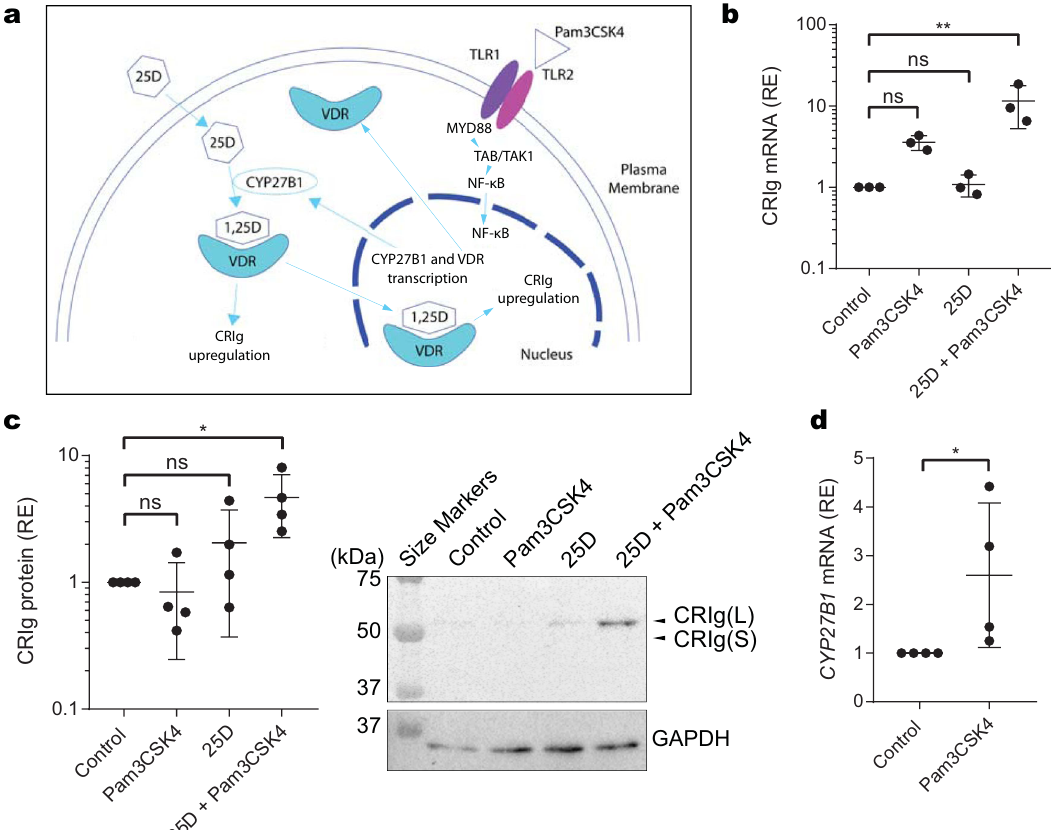
Fig. 4 Vitamin D 3 promotes CRIg expression in macrophages treated with the TLR1/2 agonist Pam3CSK4. a Schematic diagram showing engagement of TLR1/2 inducing enhanced expression of CYP27B1 which then converts 25D to 1,25D. b Macrophages matured after 3 days of monocyte culture, were treated for a further 24 h with either 50 ng/mL Pam3CSK4, 100 nM 25D or a combination of both or neither and the levels of CRIg mRNA determined. The levels were expressed relative to GAPDH mRNA (RE). Data are expressed as individual values and as means± s.d. of three experiments. c Macrophages matured after 5 days of monocyte culture, were treated as described above. CRIg expression was measured by western blot relative to GAPDH expression. Data are expressed as means± s.d. of fi ve experiments together with a representative western blot. d For CYP27B1 expression, monocytes were differentiated to macrophages for 3 or 5 day, and Pam3CSK4 or control were added for 24 h and the levels of CYP27B1 mRNA determined by qRT-PCR. b , c P values were calculated using one-way ANOVA followed by Dunnett ’ s multiple comparison test. d P value was calculated by the paired, one-tailed Student ’ s t -test. Signi fi cance of differences between the different treatments are shown, * P < 0.05, ** P < 0.01, ns = not signi fi